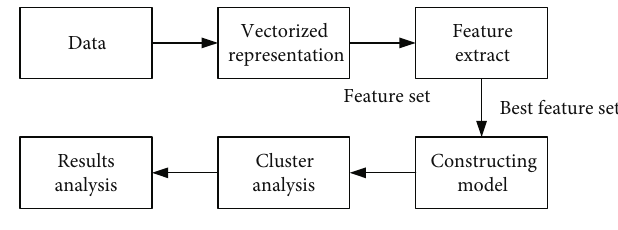
Figure 2: Clustering analysis fl